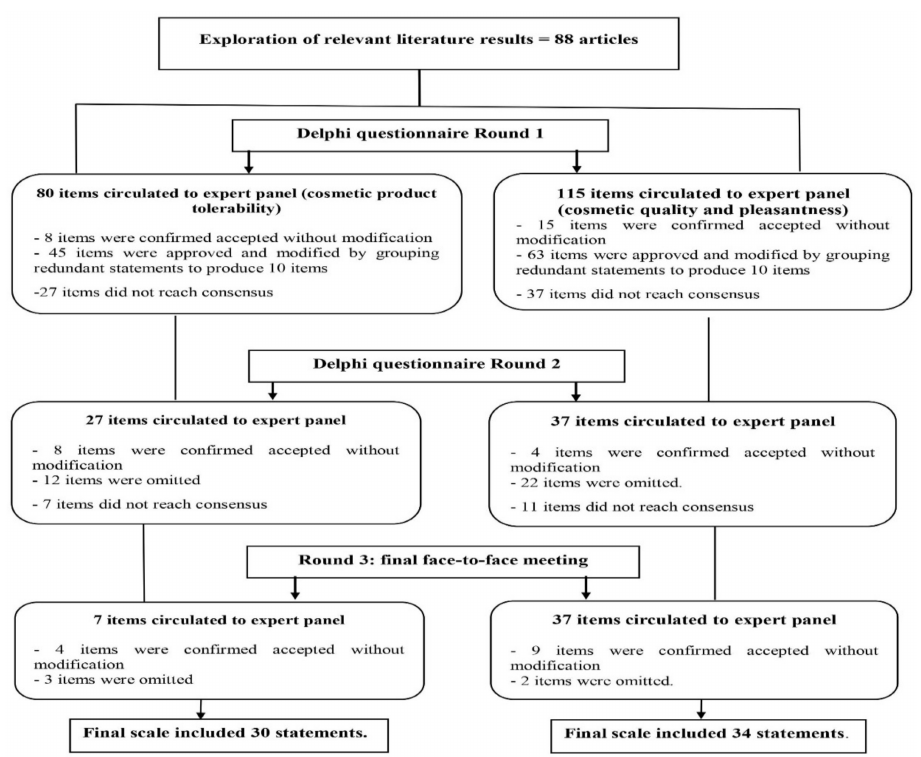
Figure 1. Modified Delphi method and